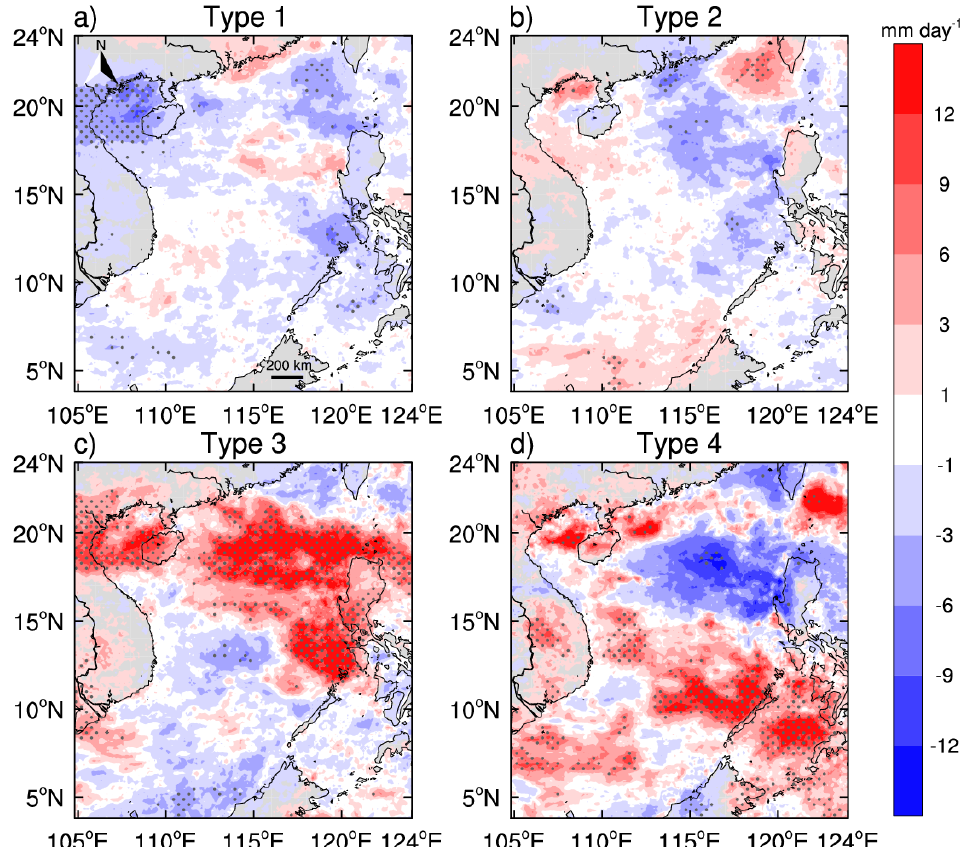
Figure 9. Rainfall anomaly (shaded, mm day −1 ) under the four synoptic types (the gray dots cover areas with significant differences): ( a ) Type 1; ( b ) Type 2; ( c ) Type 3; ( d ) Type 4. Overall, the chl-a changes in different regions of the SCS under different LSCPs may be dominated by different meteorological variables. For further quantitative analysis, Fig- ure 10 shows the anomaly percentages of meteorological variables for the three coastal regions, where chl-a changes significantly under the different LSCPs (Figure 3d). Note